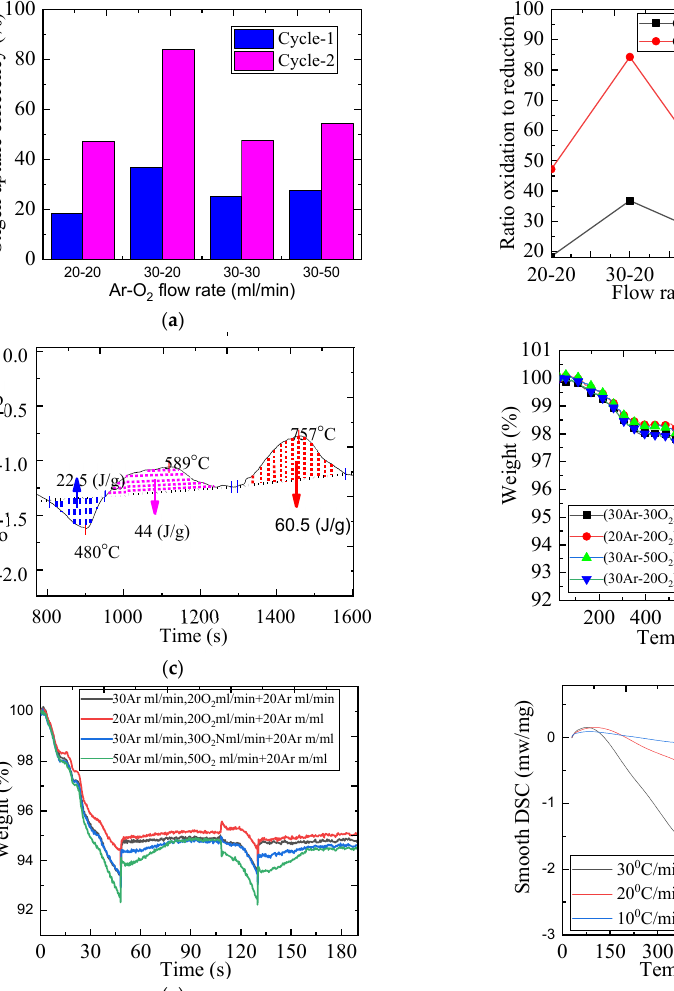
Figure 5. The impacts of different Ar and O 2 combined flow rates on the redox reaction for the (Fe,Co,Mn)Ox: ( a ) O 2 uptake efficiency with Ar-O 2 flow rates; ( b ) impact of gas flow rates on redox reaction; ( c ) DSC analysis with phase change temperature picks and enthalpies; ( d ) the impact of gas flow rates on weight loss during heating in the first cycle, and ( e ) the weight loss with time for both cyclic redox reactions including the impacts additional 20 mL/min Ar protective gas; ( f ) smooth DSC analysis in terms of heat flow curve against the variation in charging